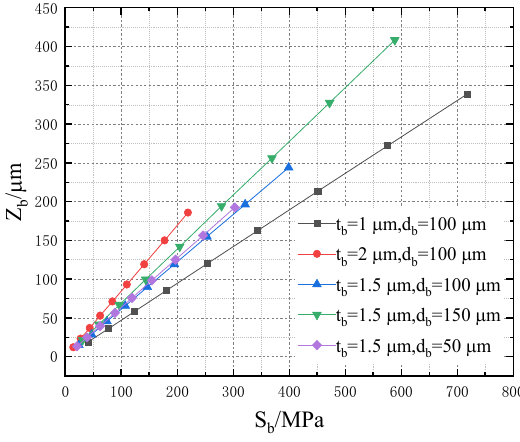
Figure 10. Relationship between 𝑍 (cid:3029) and 𝑆 (cid:3029) .